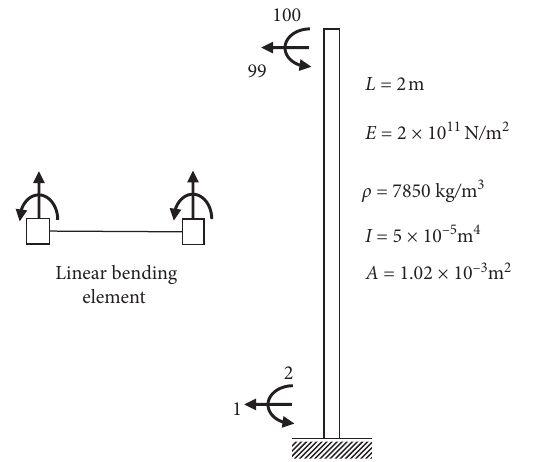
Figure 1: Cantilever beam with constant mass